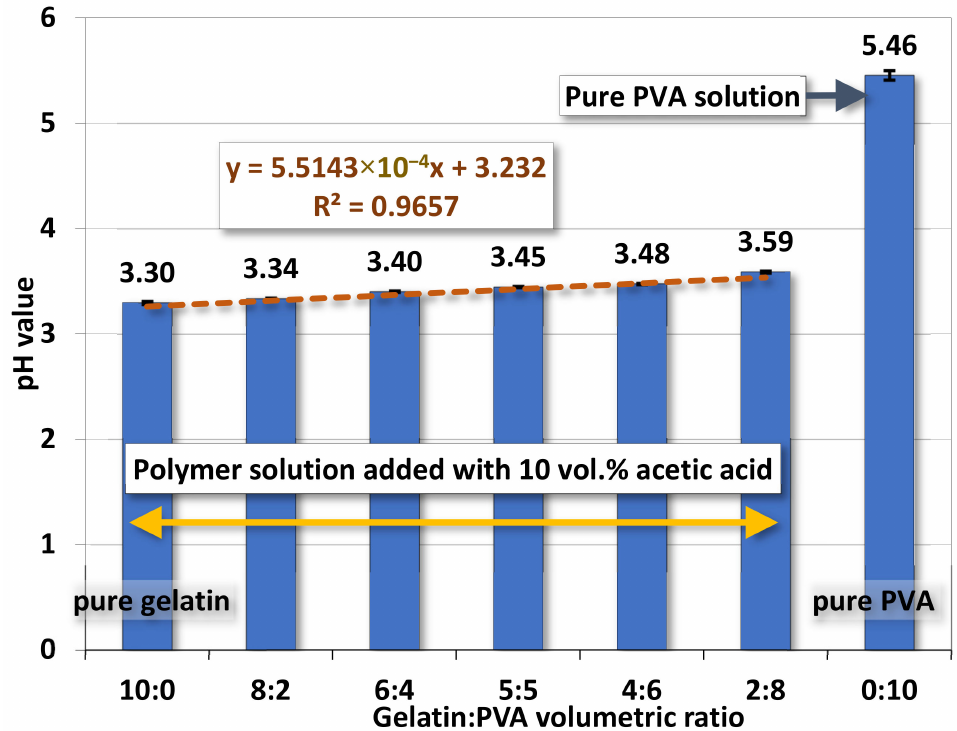
Figure 4. The average pH values of gelatin/PVA mixed solutions.